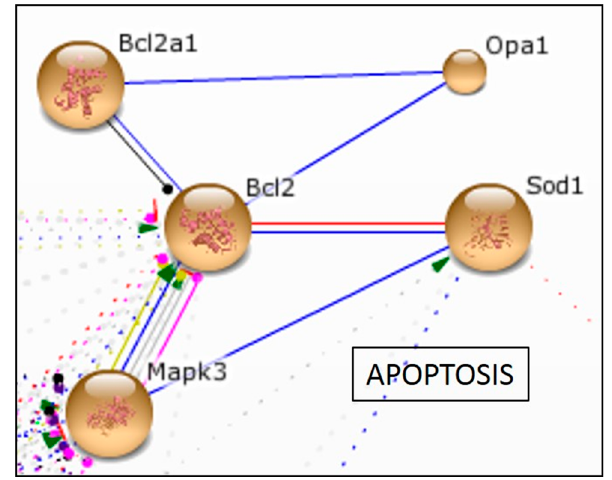
Figure 4. Aspalathin limited high glucose-induced apoptosis. STRING database analysis confirmed a strong interaction between genes associated with aspalathin treatment and regulation of high glucose induced